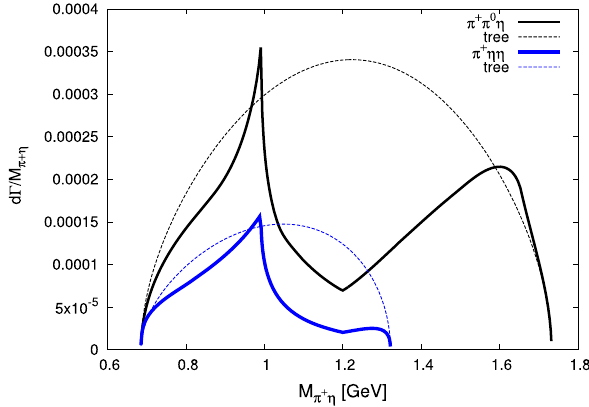
Fig. 7 Solid lines: Results for d (cid:10)/ dM inv (π + η) for D + → π + π 0 η (uppercurve)and D + → π + ηη (lowercurve).Thedashedcurvesstand for the phase space of D + → π + π 0 η (upper curve) and D + → π + ηη (lower curve). The set of parameters used, A = 1, β = 1, B = 1 / 3, γ =